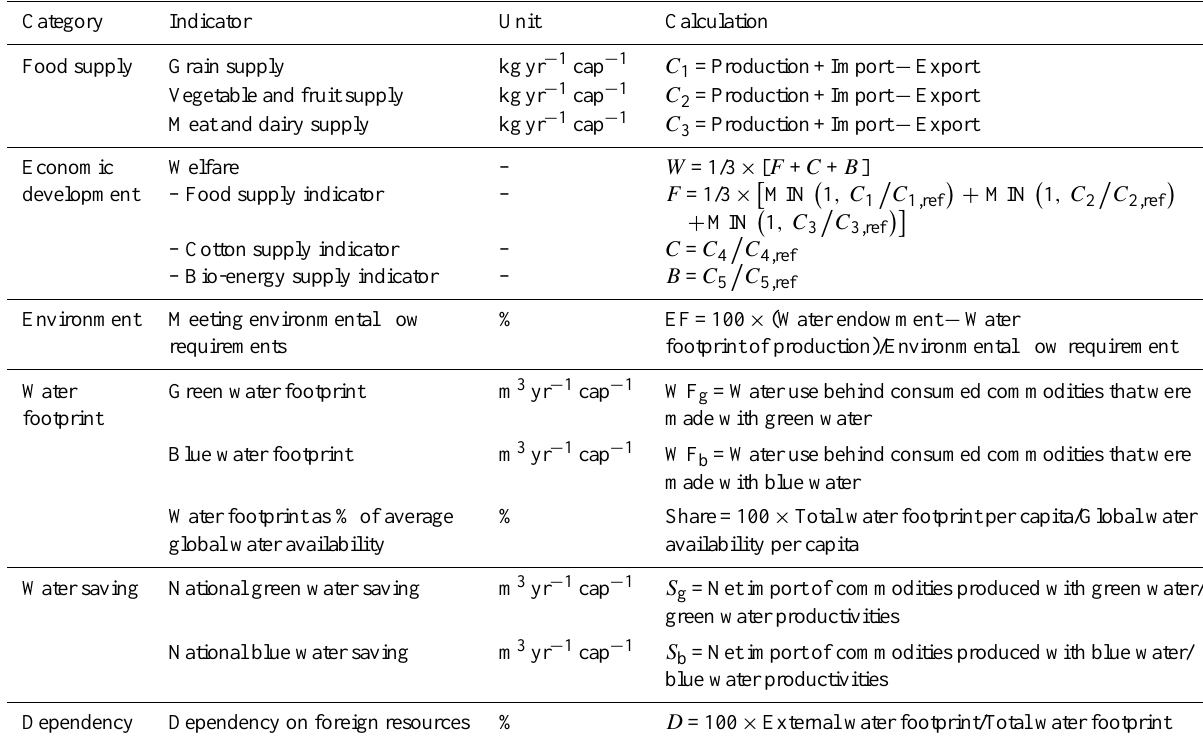
Table 4. Development indicators in the Globalization of Water Role